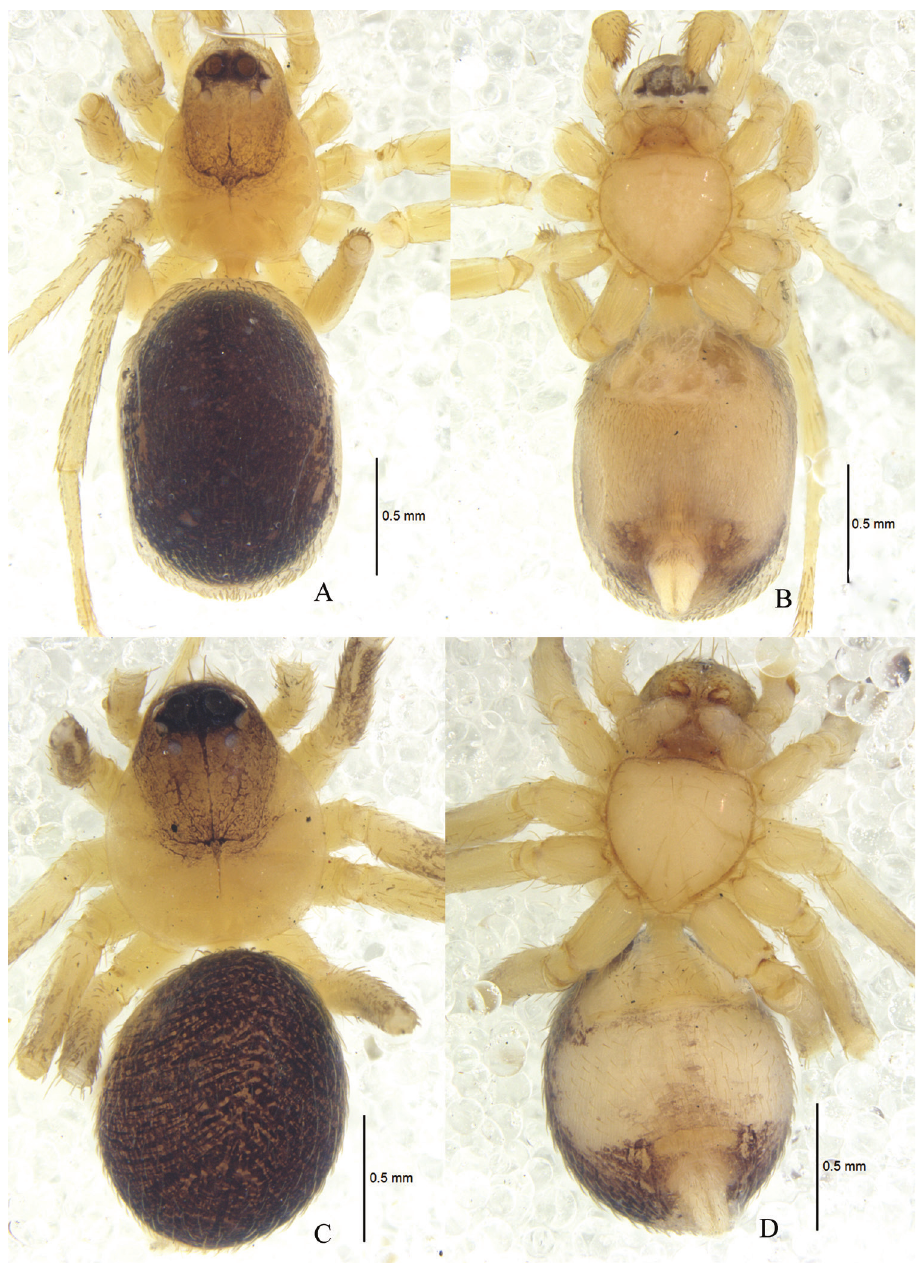
Figure 11. Zodarion furcum Zhu, 1988, male holotype ( A, B ) and female paratype ( C, D ) Habitus ( A, C dorsal view B, D ventral